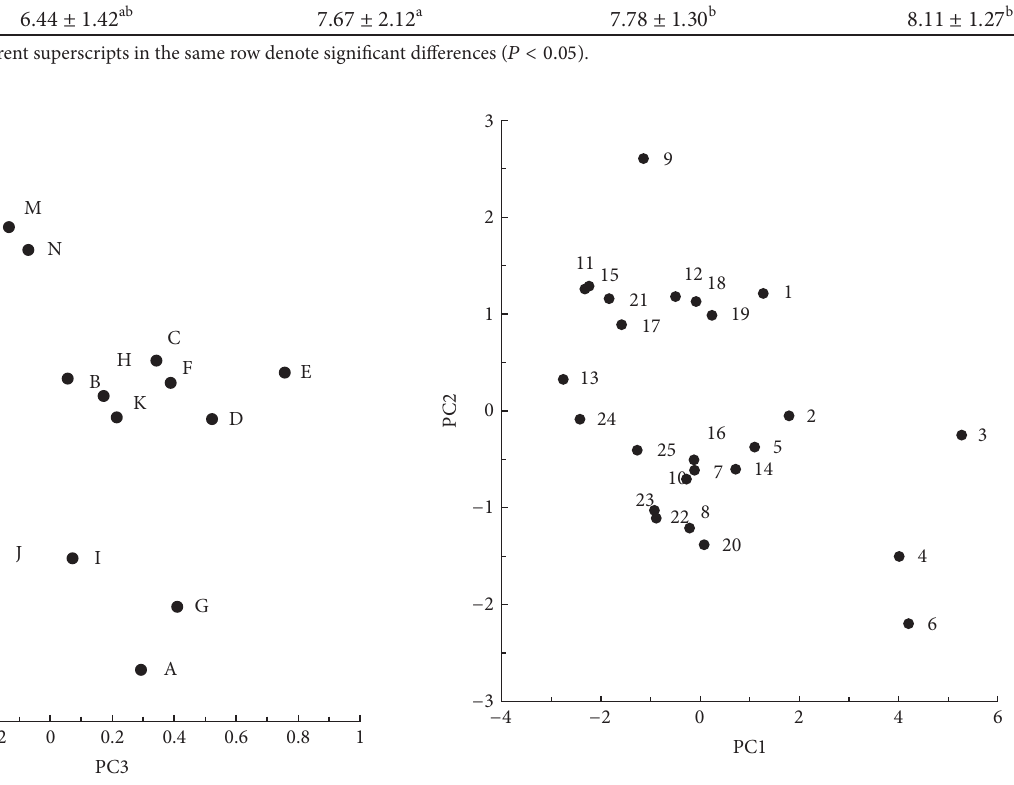
Figure 3: The score plot of samples in 1 and 2 principal components (PC1 and